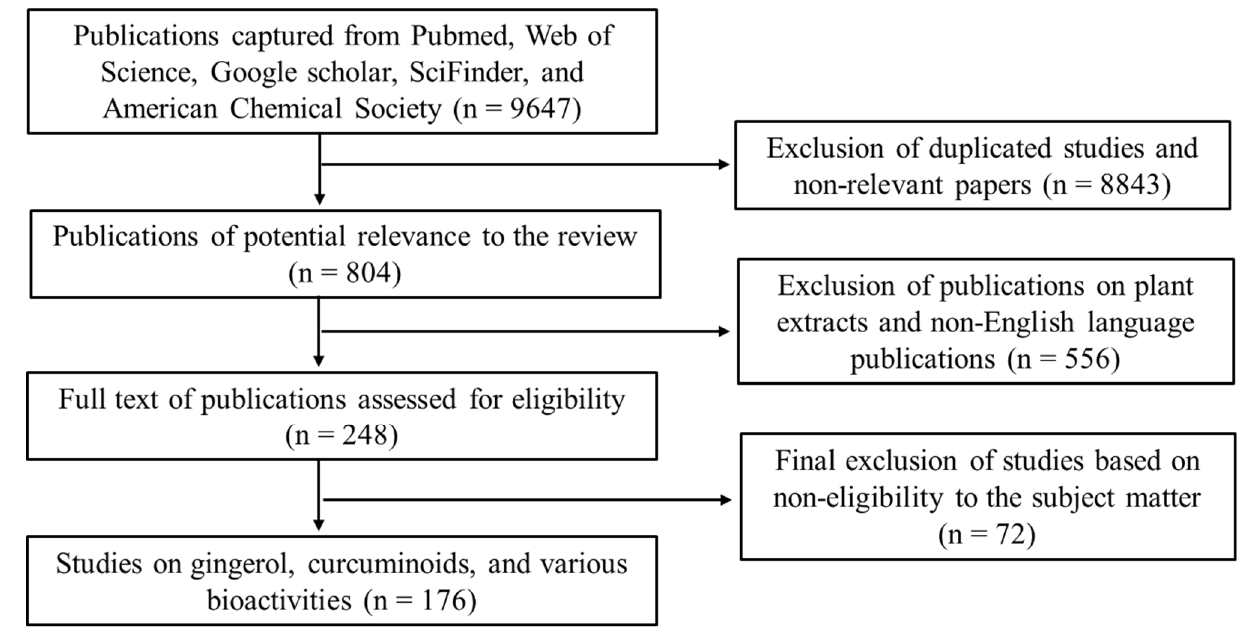
Figure 1. A flow chart of the inclusion and exclusion criteria adopted for screening and selection of publications used in this review.